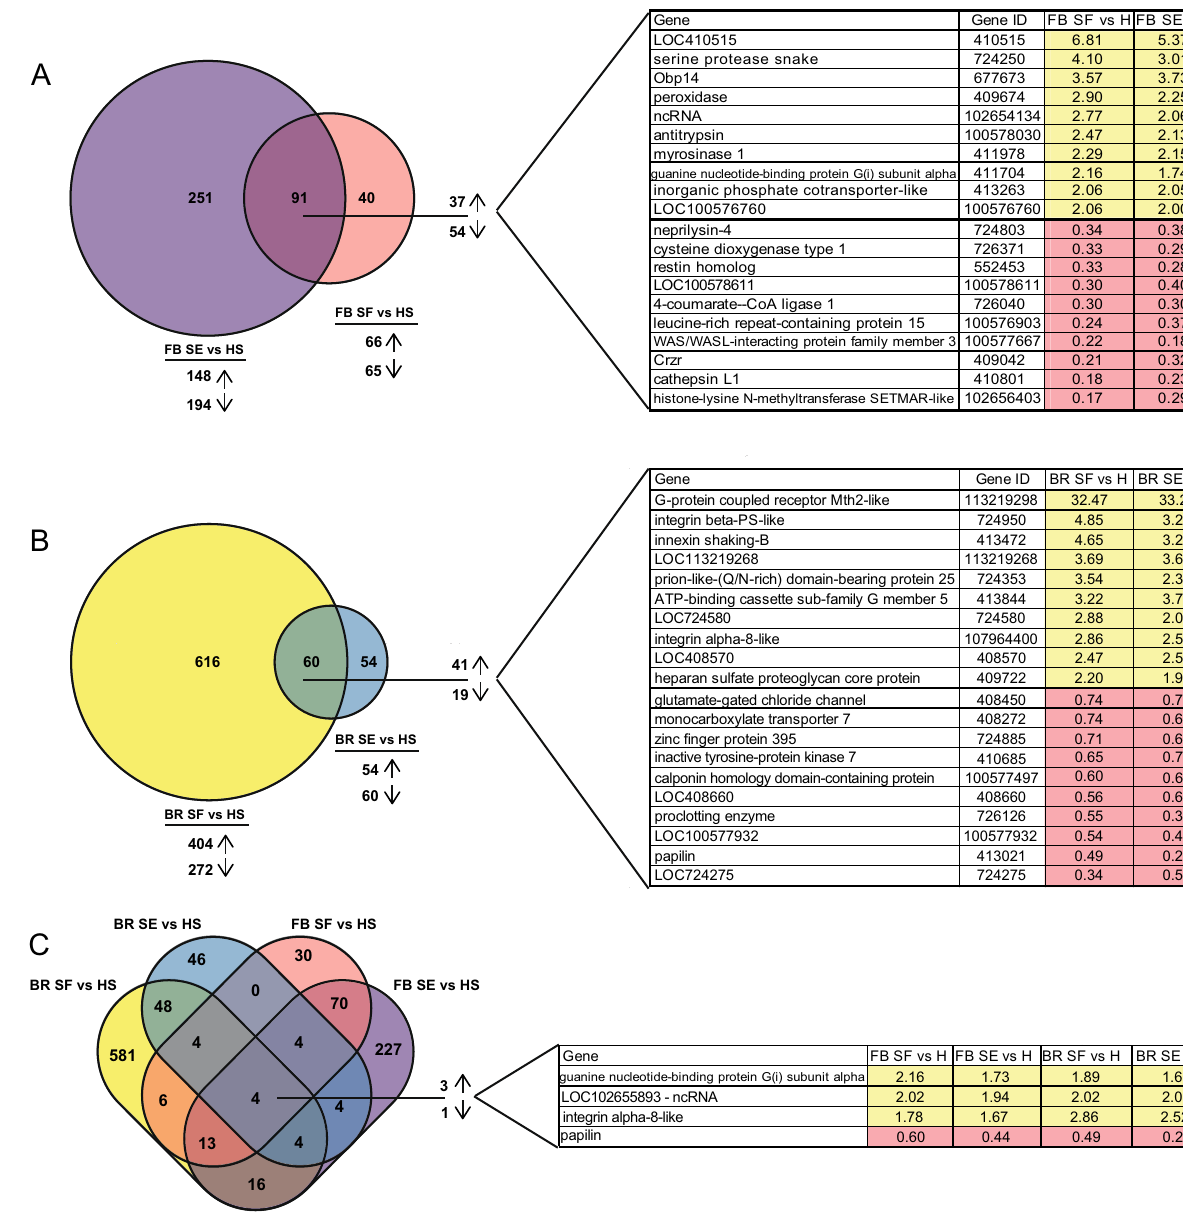
Figure 5. Venn diagram of differentially expressed genes (DEGs) in the brains and fat bodies of queens injected with semen or seminal fluid as compared to queens injected with Hayes solution. Numbers indicate number of DEGs and arrows represent number of DEGs that were upregulated and DEGs that were downregulated. ( A ) In the fat bodies, there were 131 DEGs in seminal fluid-injected queens (FB SF) as compared to Hayes-injected queens and there were 342 DEGs in queens injected with semen (FB SE) as compared to Hayes-injected queens (FB HS). There were 91 DEGs that were shared between the two pair-wise comparisons. The table displays the top ten upregulated DEGs and top ten downregulated DEGs with the greatest fold changes. ( B ) In the brains, there were 114 DEGs in queens injected with semen (BR SE) as compared to Hayes-injected queens and there were 676 DEGs in seminal fluid-injected queens (BR SF) as compared to Hayes-injected queens (BR HS). There were 60 DEGs that were shared between the two pair-wise comparisons. The table displays the top ten upregulated DEGs and top ten downregulated DEGs with the greatest fold changes. ( C ) Venn diagram analysis was performed to determine shared DEGs in the four pairwise comparisons: FB SF vs HS, FB SE vs HS, BR SF vs HS, and BR SE vs HS. There were four DEGs that were shared between the four pair-wise comparisons that exhibited the same direction in expression fold change. The table displays all shared DEGs and their respective fold changes in the four pair-wise